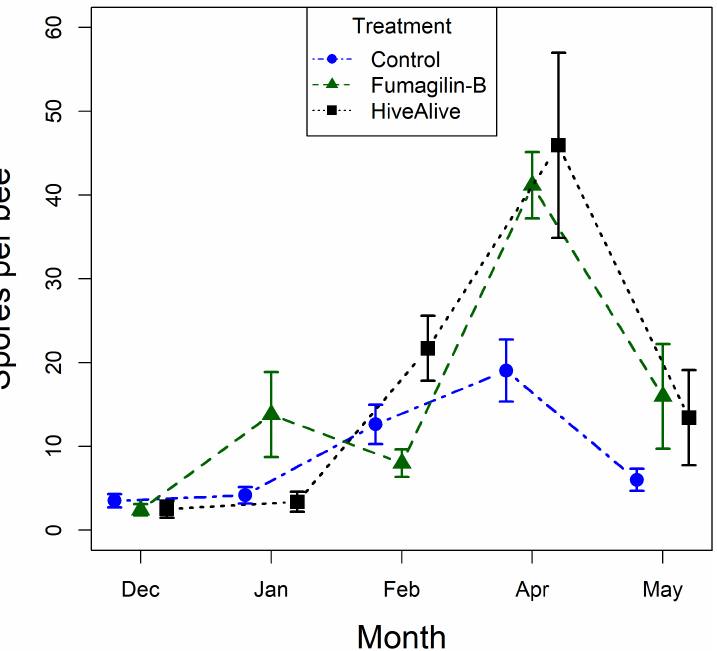
Figure 2. Vairimorpha spp. spores per bee (×50,000) in Experiment 2. Shapes and error bars represent mean and standard error. Treatments are: control (blue circles), Fumagilin-B ® (green triangles), and